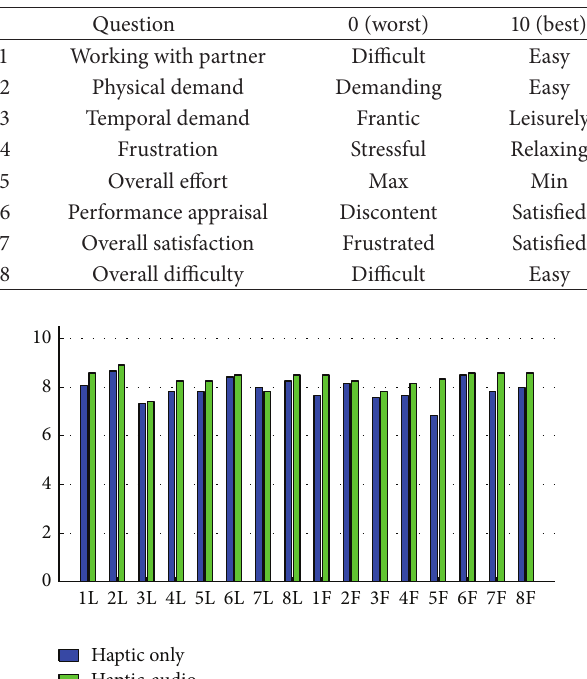
Table 1: The modified NASA TLX postexperimental survey.